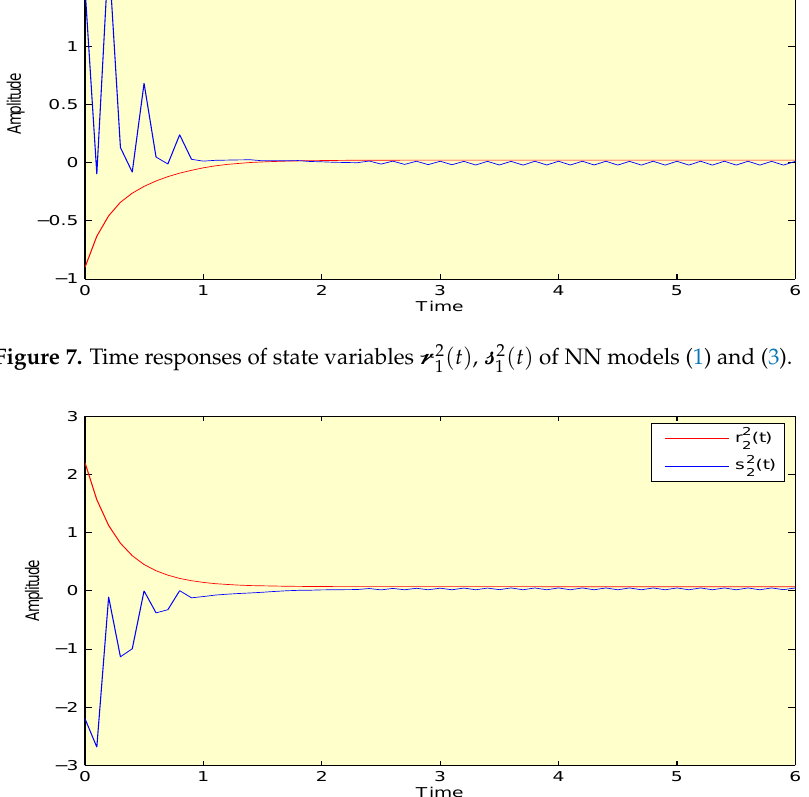
Figure 8. Time responses of state variables (cid:114) 2